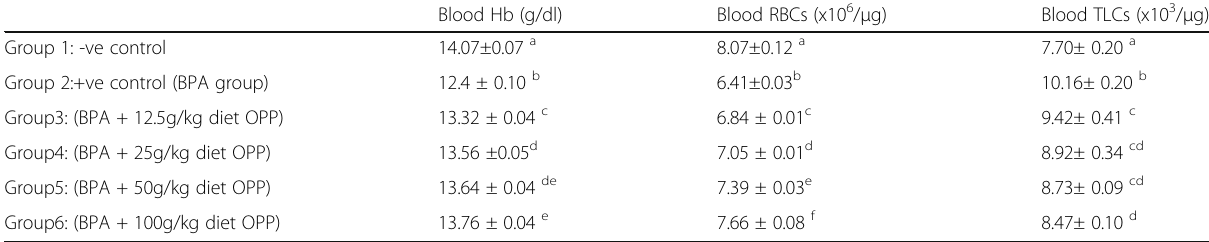
Table 4 The effect of orange peel powder against BPA action on blood Hb, RBCs, and TLCs in BPA-treated